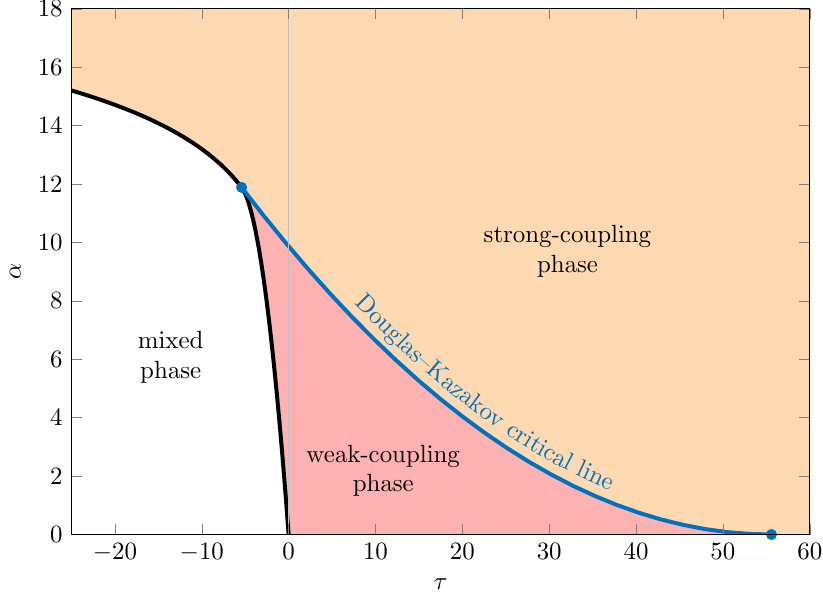
Figure 1 . The phase diagram of the theory at large N has three phases: weak coupling, strong coupling, and mixed coupling. The blue line is the deformed Douglas-Kazakov critical line, associ- ated with a third-order phase transition. The black line is a critical line associated with a second order-phase transition. The two lines join at a multicritical point represented by a blue dot. The thin gray line at τ = 0 corresponds to the undeformed